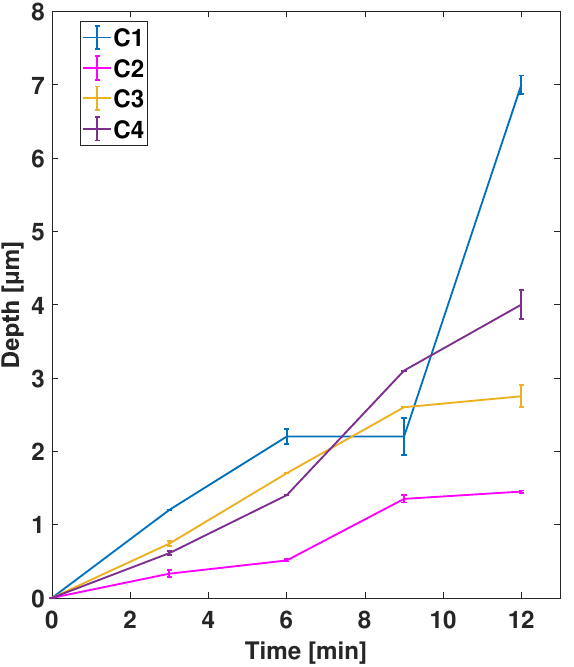
Figure 8. Average etch depths of brick wall and fishbone catalysts processed on the same Si chip as a function of etching time at MACE conditions C1–C4. The error bars show the standard deviation of the measurements.